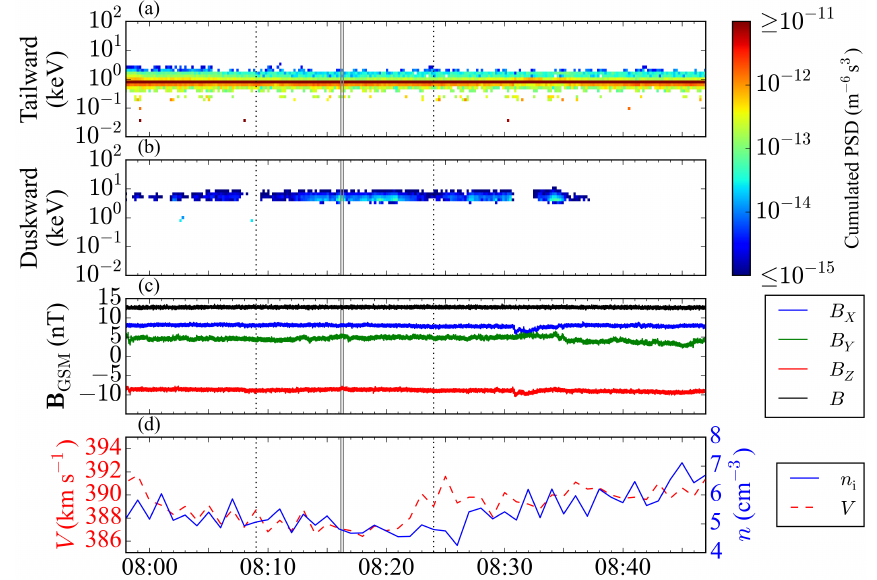
Figure 11. Geotail/LEP energy–time spectrogram on 30 August 2004 between 07:48 and 08:47UT, for the (a) tailward and (b) duskward sectors ( ± 45 ◦ from the + x and + y direction respectively), extracted from the two-dimensional reduced velocity distribution in the GSE ecliptic plane. The tailward sector shows the cold and dense solar wind core population just below 1keV. The duskward sector shows the signature of a transient beam whose density peaks several times between 08:09 and 08:24UT (time delimited by the black dotted lines). (c) Geotail/MGF magnetic field in GSM coordinates. The magnetic field components and thus its orientation are stable during the event. The short-period oscillations coincide with Geotail’s nominal spin rate of 20rpm. (d) OMNI plasma number density and velocity. The grey continuous bars indicate the time at which the velocity distribution shown in Fig. 12 is